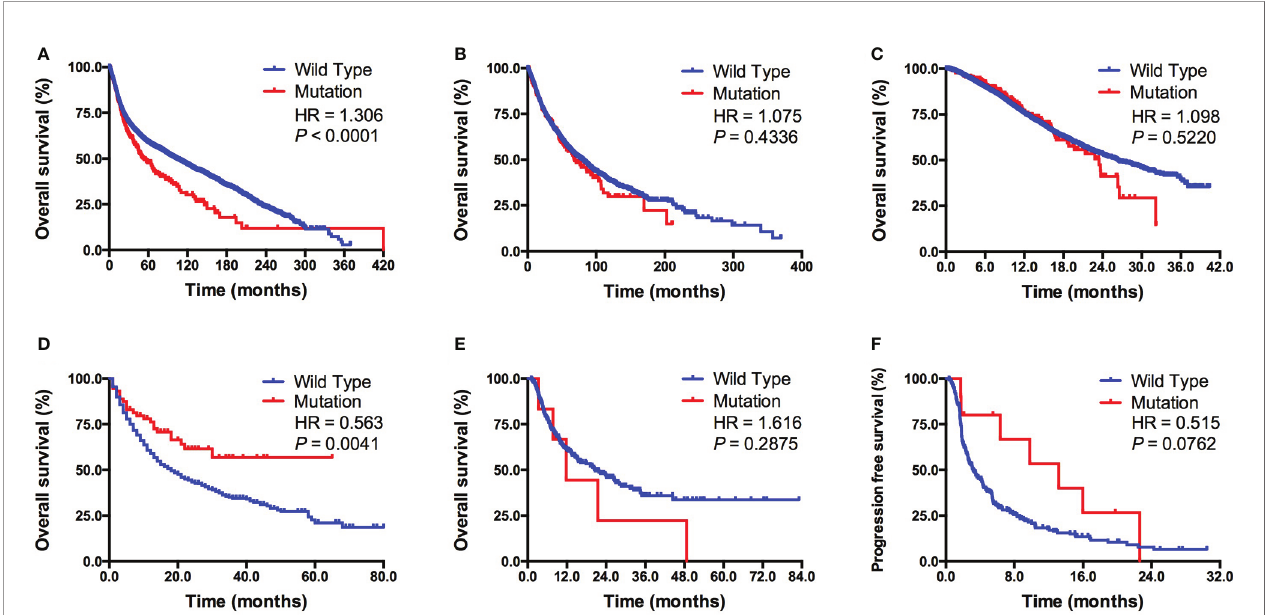
FIGURE 3 | Association between KDM5C alterations and clinical outcome. (A) Prognostic value of KDM5C alterations in all cancers; (B) Prognostic value of KDM5C alterations in TCGA cohort; (C) Prognostic value of KDM5C alterations in MSK-IMPACT cohort; (D) Predictive value of KDM5C alterations in ICI treated cohort; (E) Predictive value of KDM5C alterations in patients with microsatellite-stable solid tumors; (F) Predictive value of KDM5C alterations in patients with non-small-cell lung cancer patients received ICI